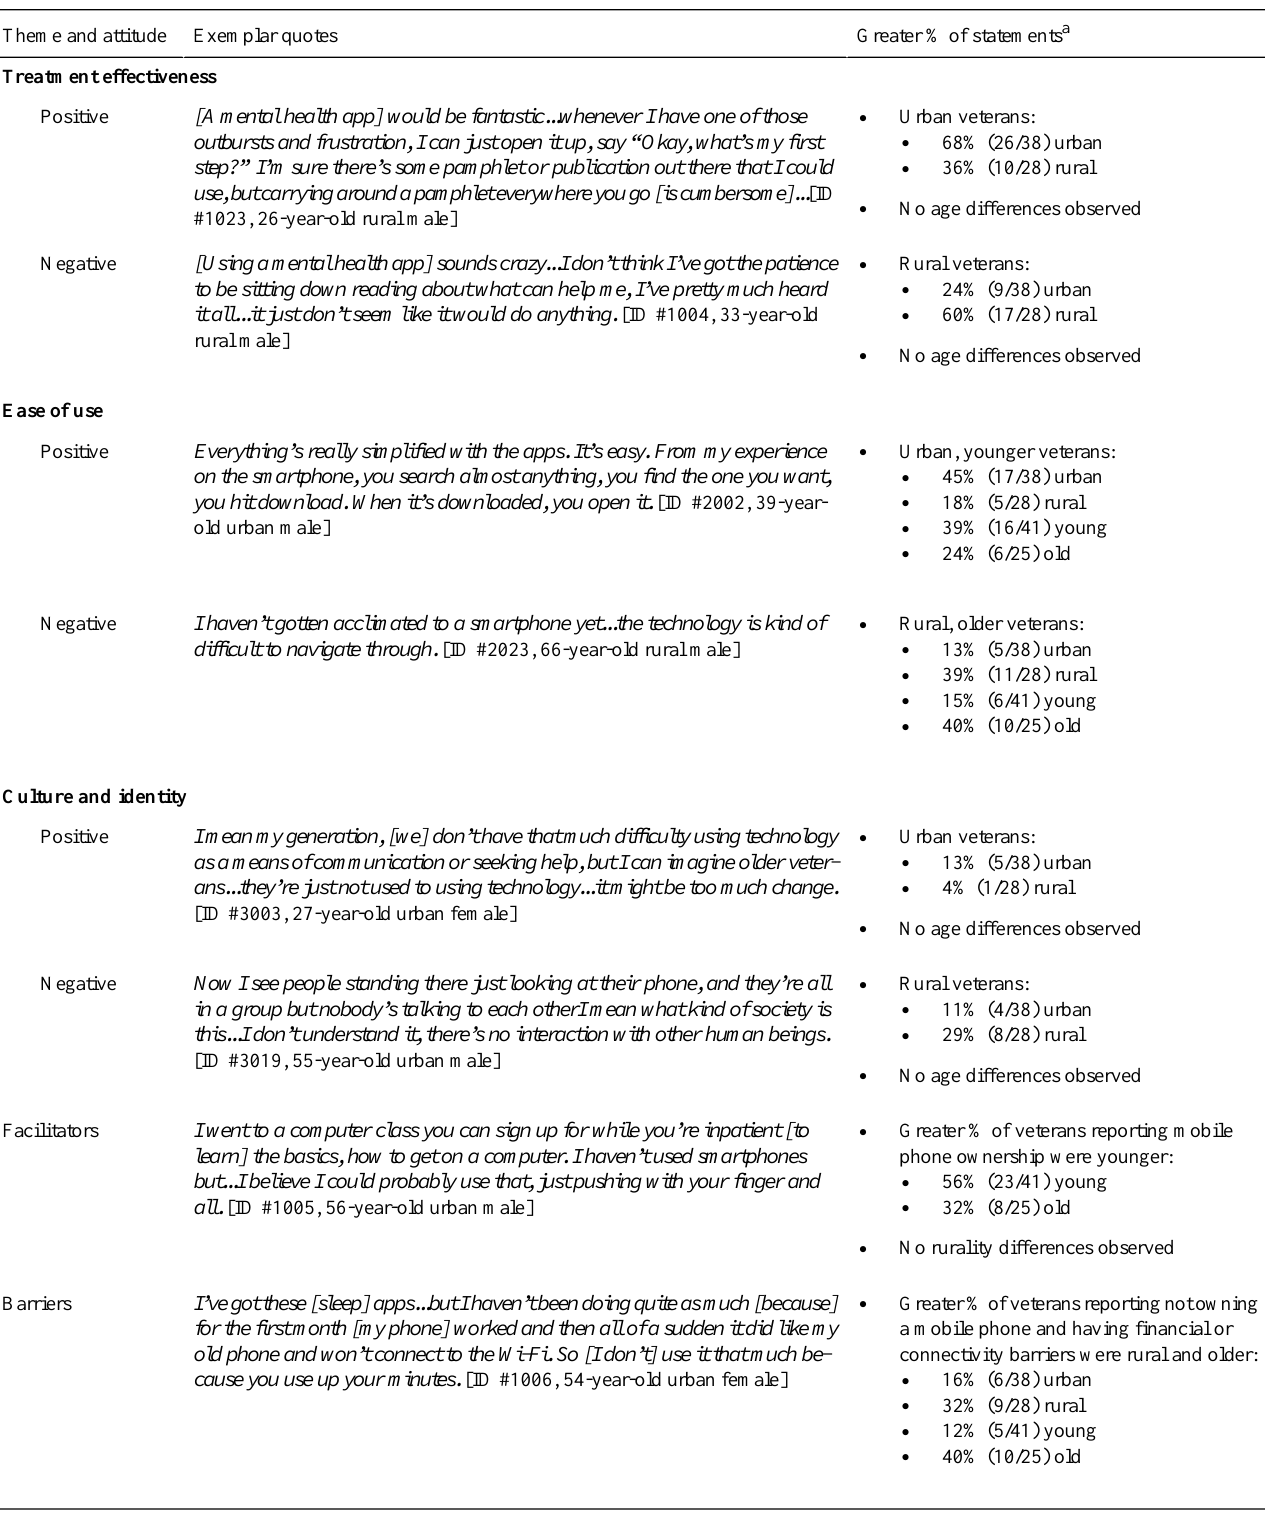
Table 2. Primary themes: exemplar quotes and rurality and age differences. Treatment